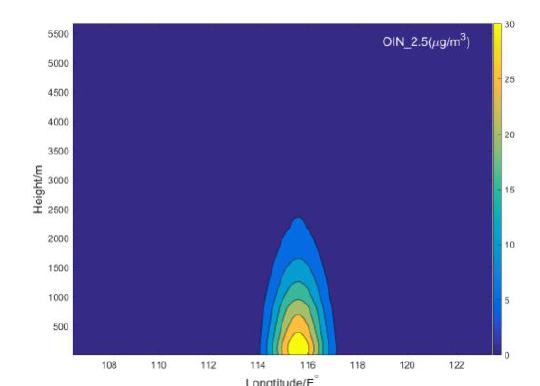
Figure 6 Mass concentrations distribution vertically of the